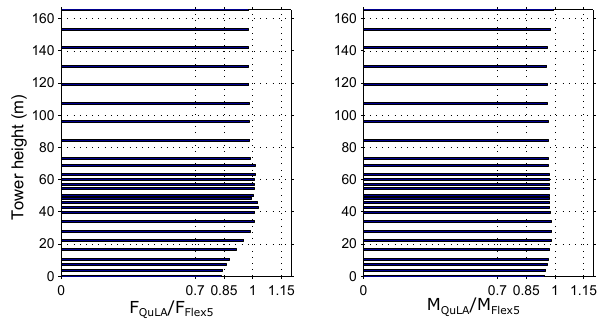
Figure 17. The ratio of the ultimate loads of QuLA to those of Flex5 for load case 1.3 in all sections in the tower and Mono